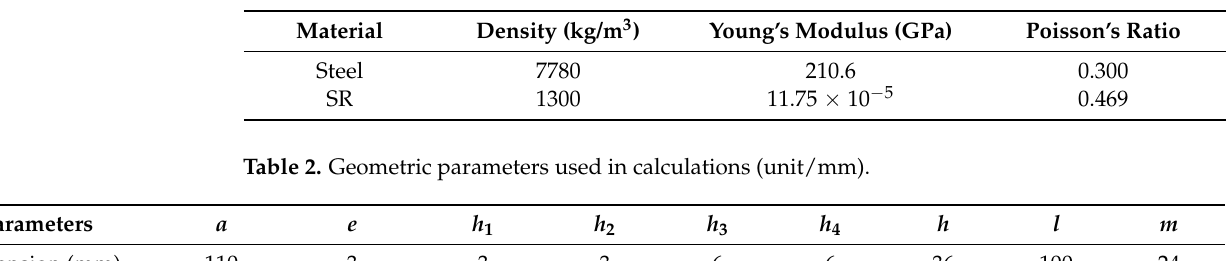
Figure 1. ( a ) S-type oscillator. ( b ) Phononic crystal plate cell structure. ( c ) Phononic crystal plate structure. Table 1. Materials’ parameters used in calculations. Table 1. Materials’ parameters used in calculations.